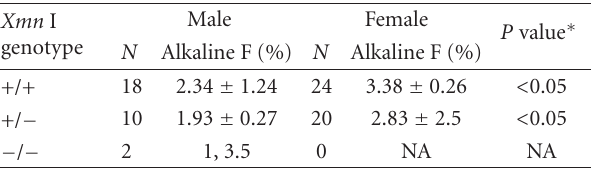
Table 2: Comparison of alkaline F % ( ± SD) in homozygous HbE with di ff erent Xmn I